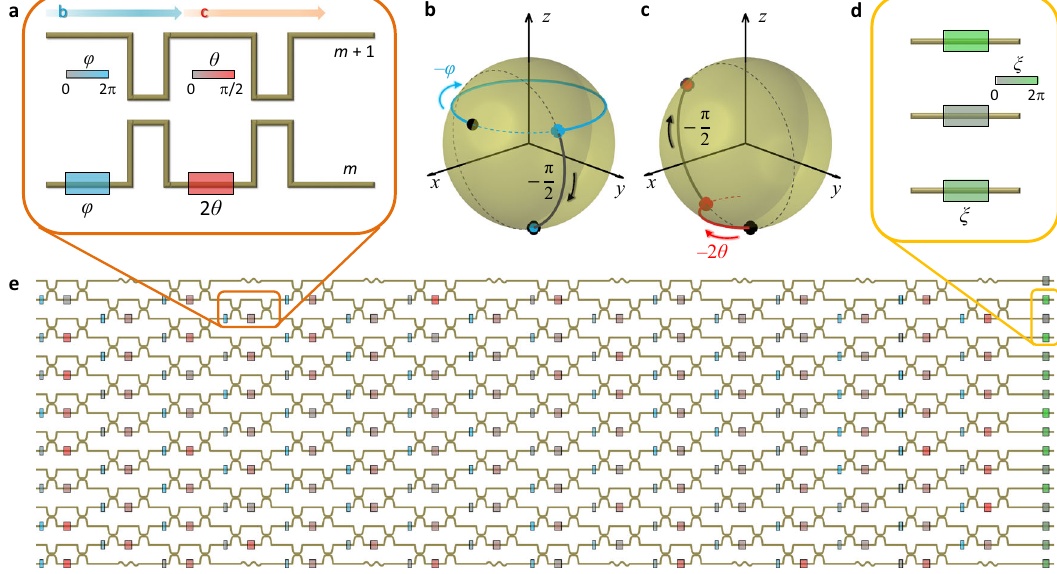
Fig. 1 | Programmable photonic circuits for universal unitary operators. a Programmable photonic building block of T m l composed of MZIs and phase shifters for the SU(2) operation between the m th and ( m +1)th channels. Red and blue boxes represent the phase shifters for θ and φ , respectively. b , c The rotation operators of R x m ( – π /2) R z m ( – φ ) ( b ) and R x m ( – π /2) R z m ( – 2 θ ) ( c ), described in Bloch